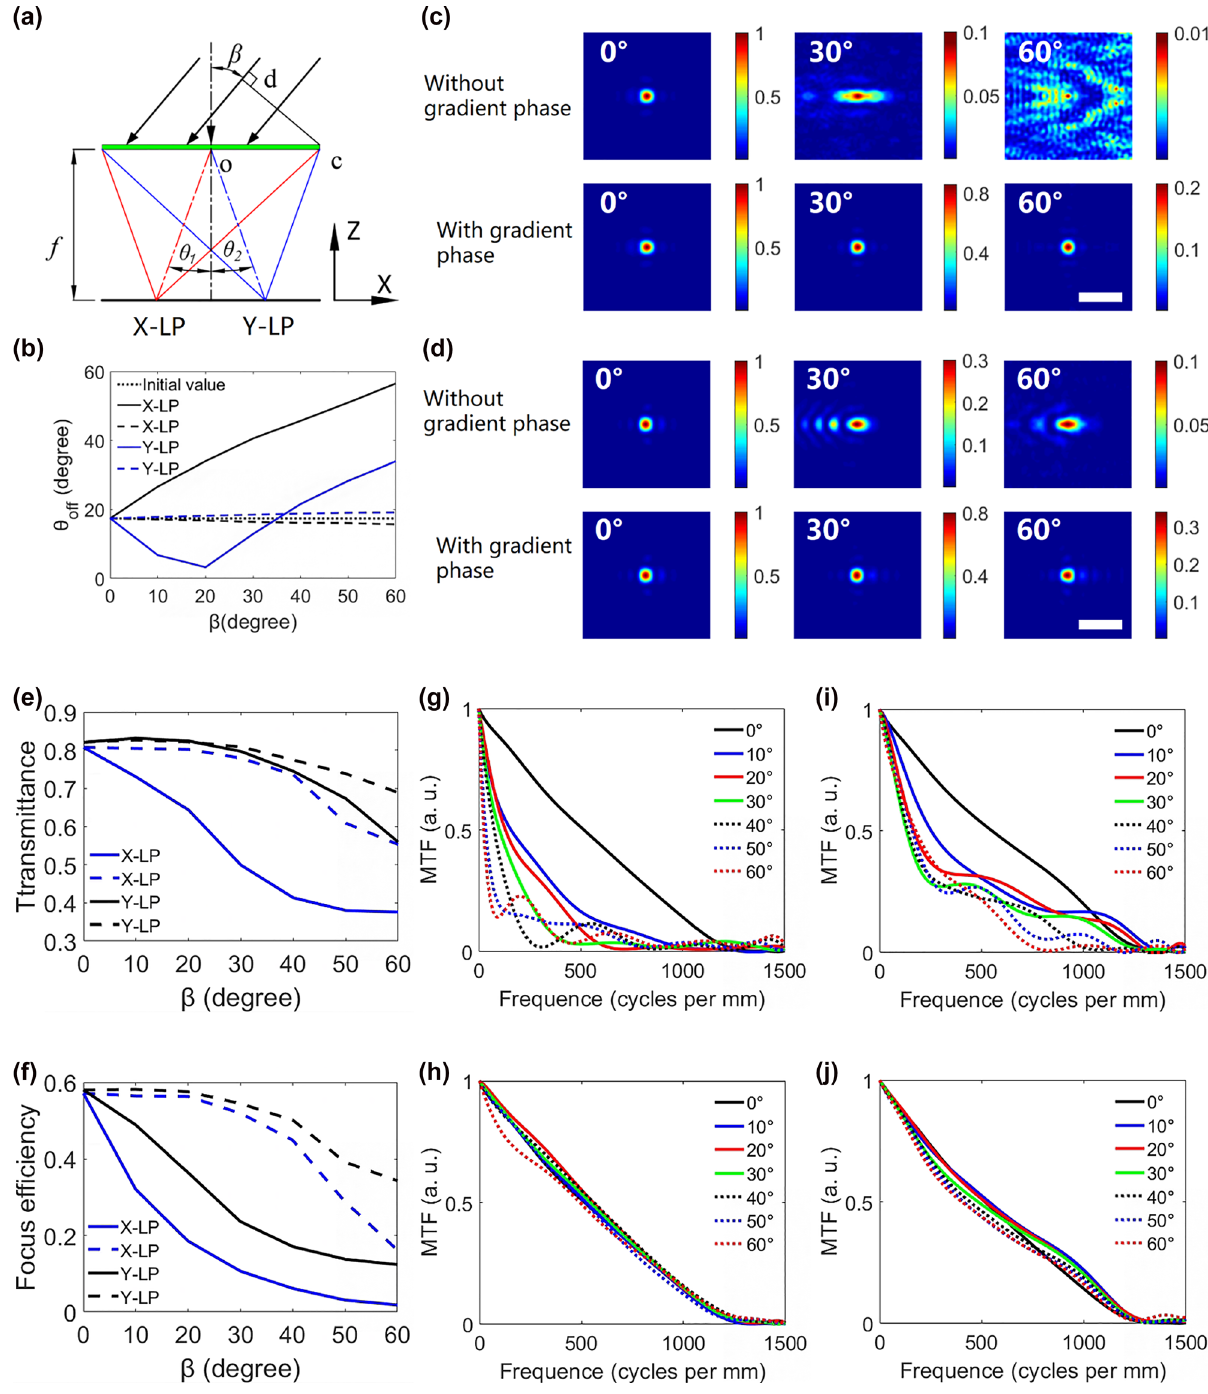
Figure 3: Theoretical analysis and numerical simulation of the metalens. (a) Schematic diagram of the optical path of the bifocal metalens in the XOZ plane, where 𝜃 and 𝜃 are the off-axis angles of the X-LP and Y-LP components, respectively. The line cd represents the optical path difference 1 2 between the oblique light vector and the vertical light vector on the bifocal metalens. (b) When 𝛼 = 0, the off-axis angles of the X-LP and Y-LP components in (a), where the solid and dashed lines represent the traditional bifocal metalens and the bifocal metalens with gradient phase, respectively, and the dotted line represents the initial value. (c) and (d) When 𝛼 = 0, the focused spots of X-LP and Y-LP components of the two bifocal metalenses at different elevation angles, respectively. Scale bar: 3 μ m. (e) and (f) When 𝛼 = 0, the transmittance and focusing efficiency of the two bifocal metalenses, the solid and dashed lines represent the traditional bifocal metalens and the bifocal metalens with gradient phase, respectively. (g) and (h) MTFs of the X-LP components at different elevation angles for the traditional bifocal metalens and the bifocal metalens with gradient phase, respectively. (i) and (j) MTFs of the Y-LP components at different elevation angles for the traditional bifocal metalens and the bifocal metalens with gradient phase,